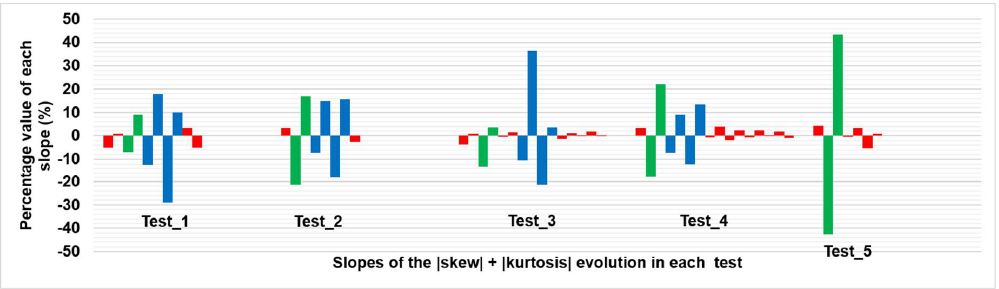
Figure 9. Alternative graphic representation of Figure 7.